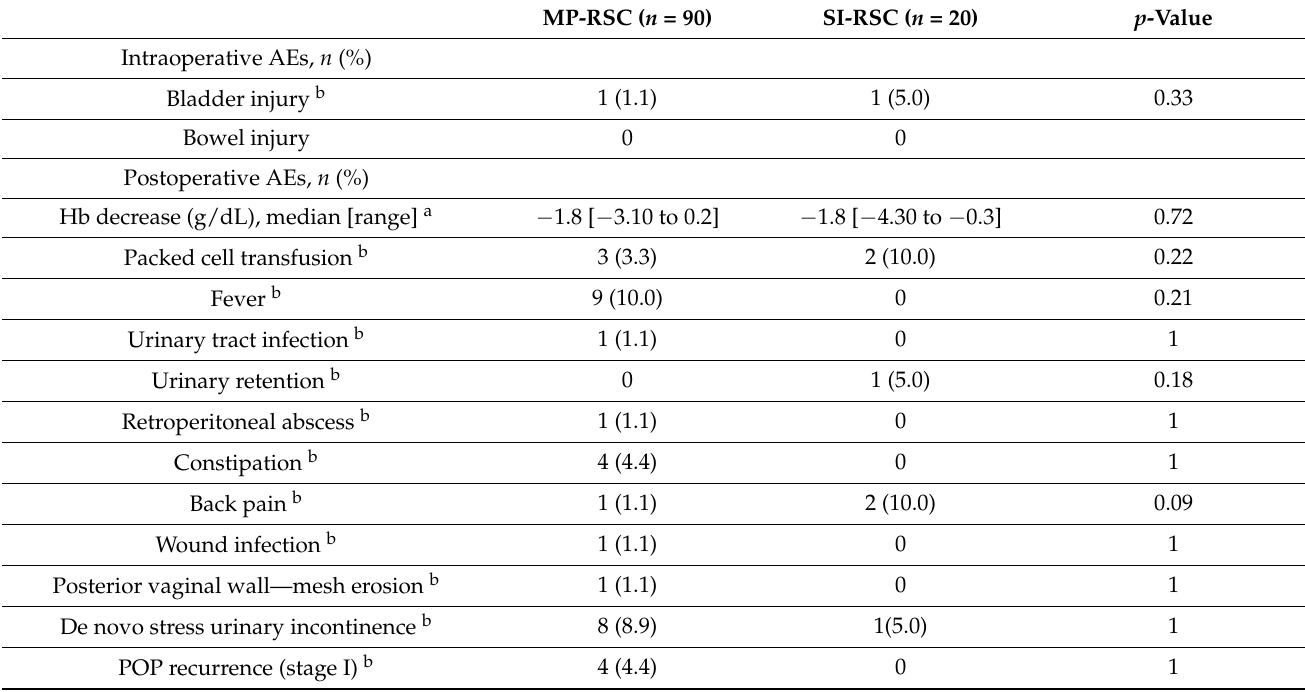
Table 5. Comparison of intraoperative and postoperative adverse events excluding patients with a history of hysterectomy. MP-RSC ( n =